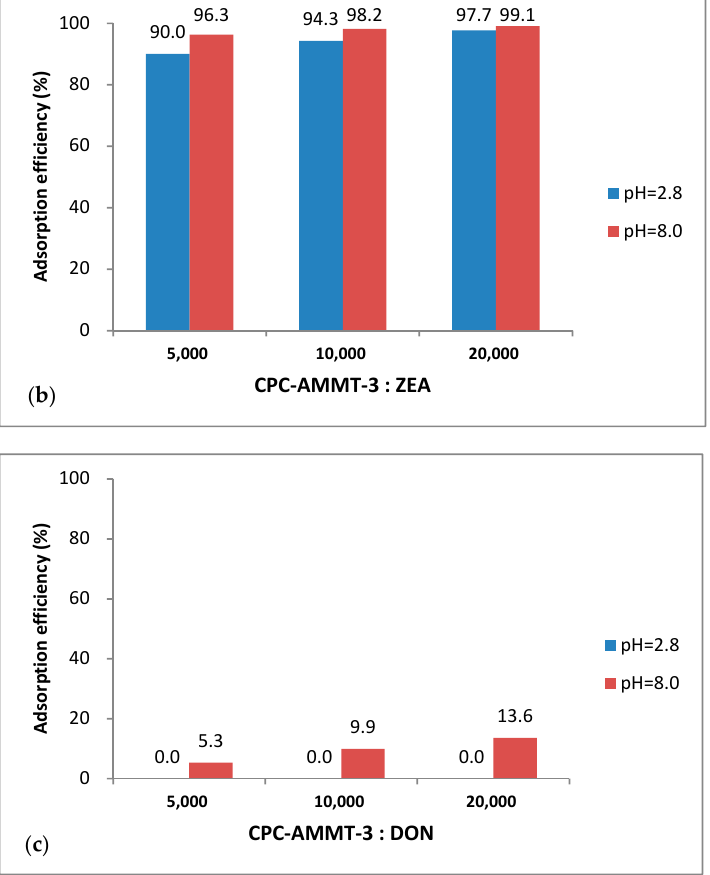
Figure 6. Adsorption efficiency of AFB1( a ), ZEA( b ) and DON( c ) with different montmorillonite/mycotoxin mass ratios.